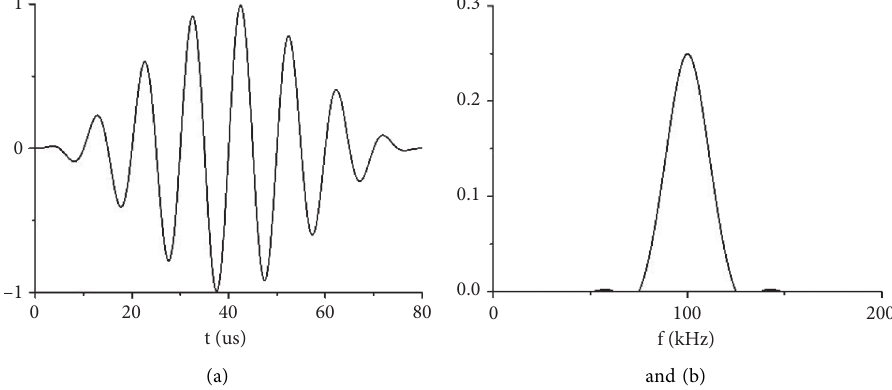
Figure 6: Excitation signal: (a) temporal waveform and (b) frequency spectrum.